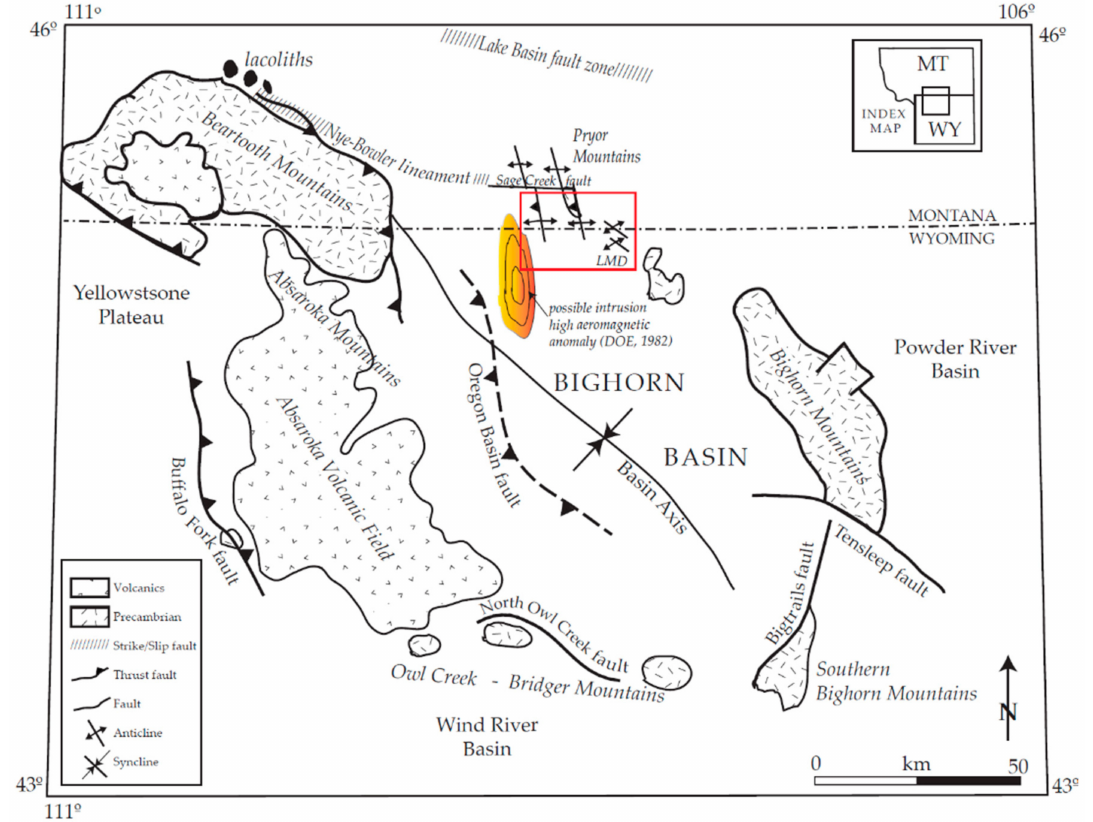
Figure 3. Map showing the tectonic features of the Bighorn Basin (BHB). Precambrian cored arches and volcanics are represented by stippled patterns. The Lake Basin fault zone, volcanic domes (lacoliths) of the Nye-Bowler lineament, Sage Creek fault zone are shown in the top portion of the figure. The location of the mining districts is outlined by the red rectangle. Map modified from Blackstone [26] and Stahl